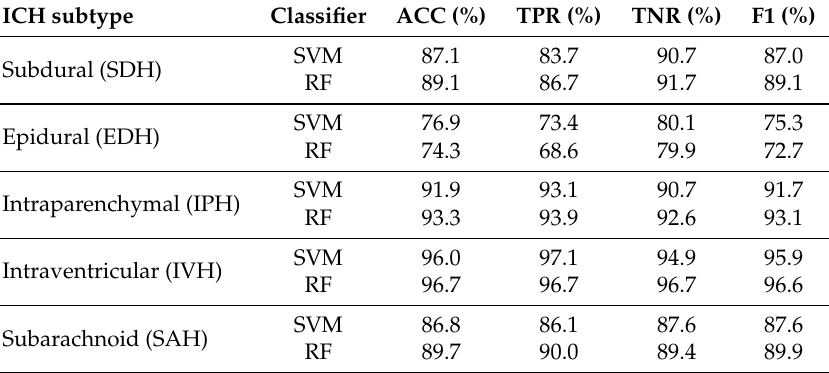
Table 3. Summary of evaluation metrics obtained in Experiment #2 for individual ICH subtypes and